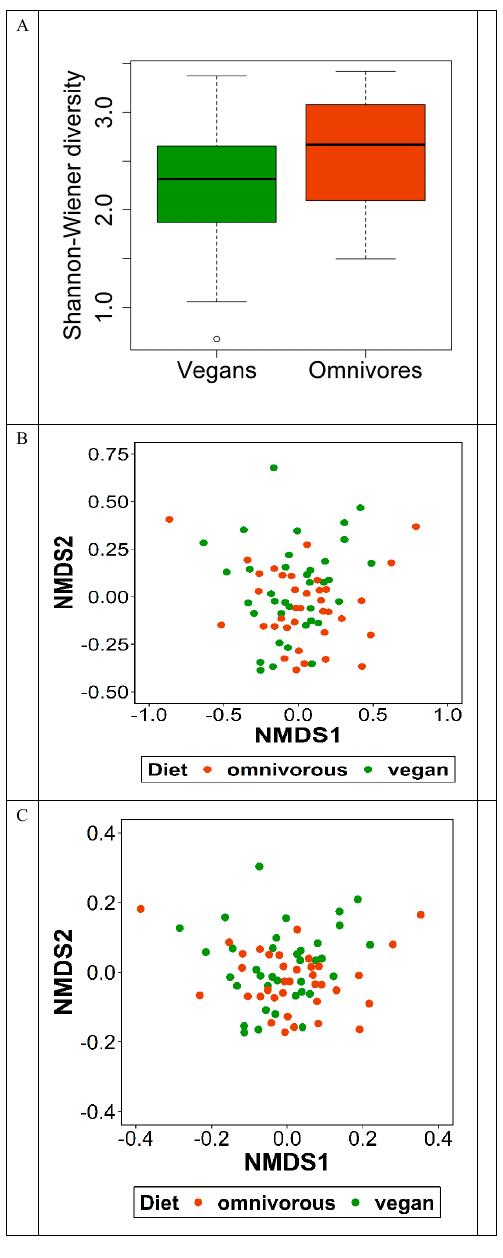
Figure 2. Alpha and beta diversity of gut microbiota in RBVD. Alpha diversity presented as Shannon Index ( A ). Beta diversity in vegans and omnivores presented as ( B ) Bray–Curtis and ( C ) Jaccard